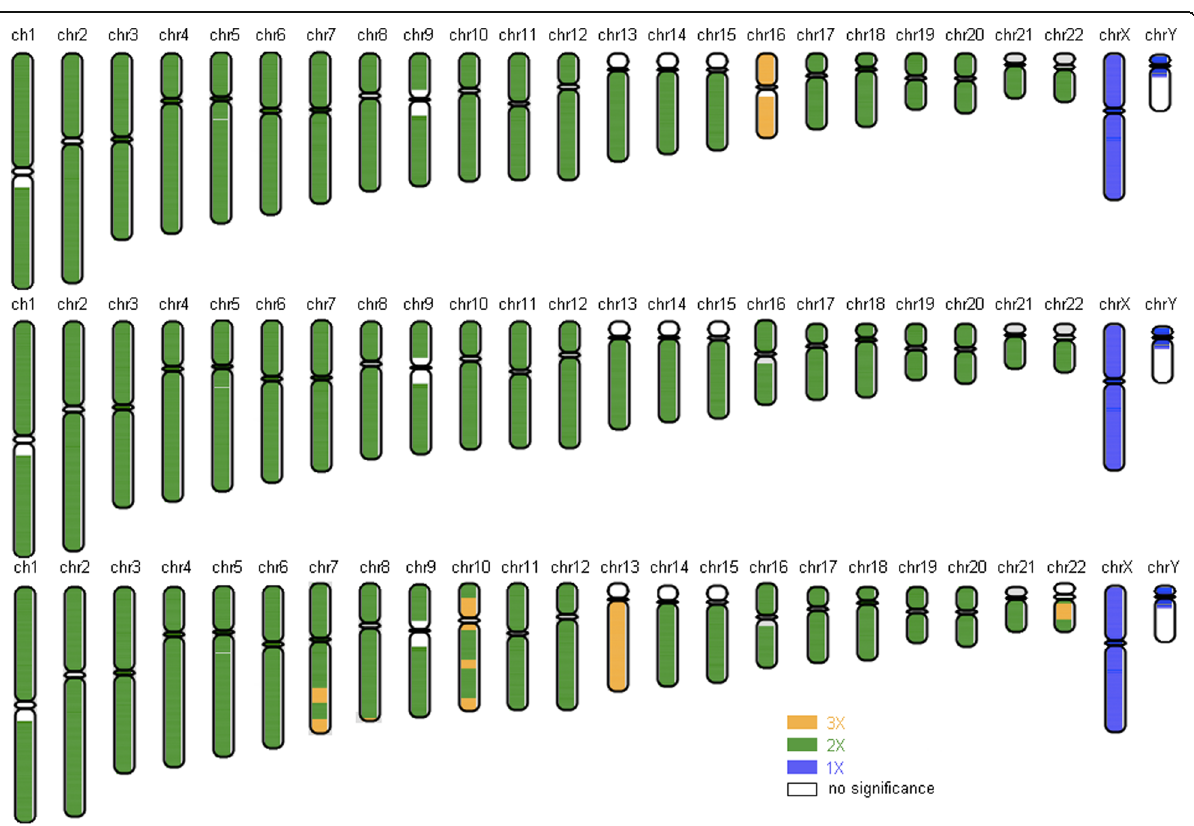
Fig. 3 Comprehensive aneuploidy screening results for embryos 3 (upper), 7 (middle), and 8 (lower). White, blue, green, and yellow denote the copy numbers of the chromosome segments, which are shown on the lower right side. Embryo 7 was euploid, and embryos 3 and 8 exhibited trisomy 16 and trisomy 13 ,